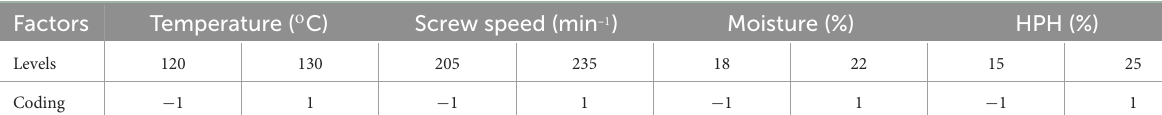
TABLE 5 2 4 factorial design with reserved levels.